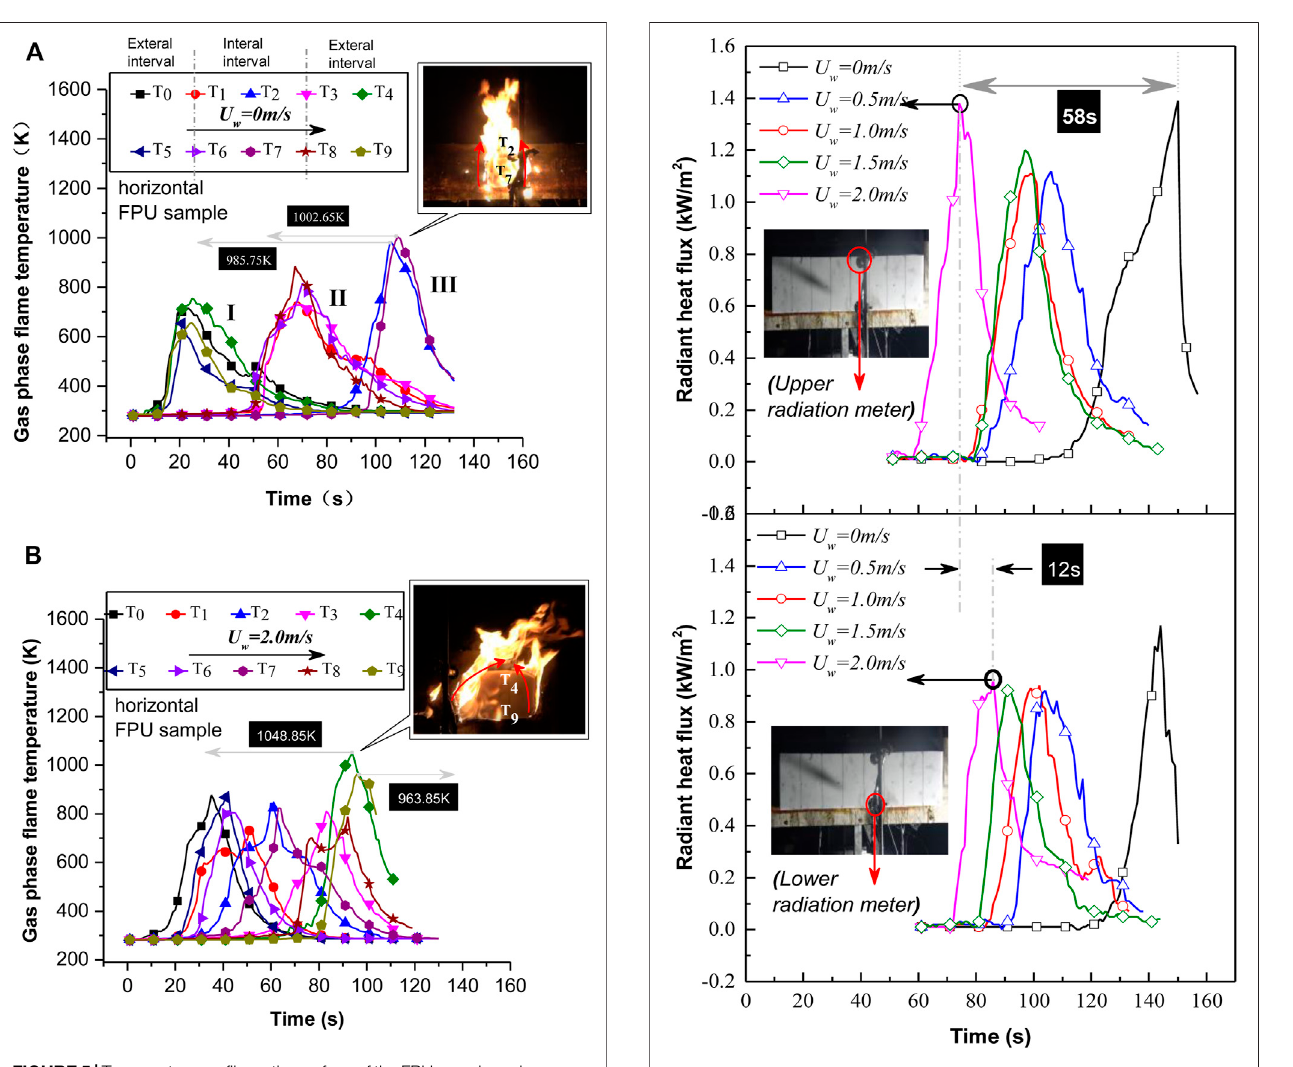
Frontiers in Energy Research |